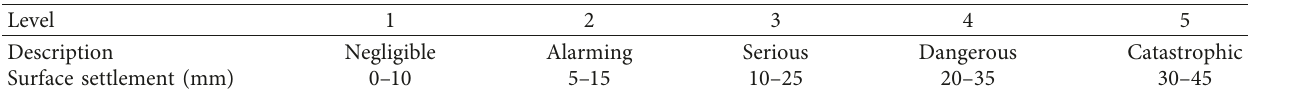
Table 2: Classification of risk levels.